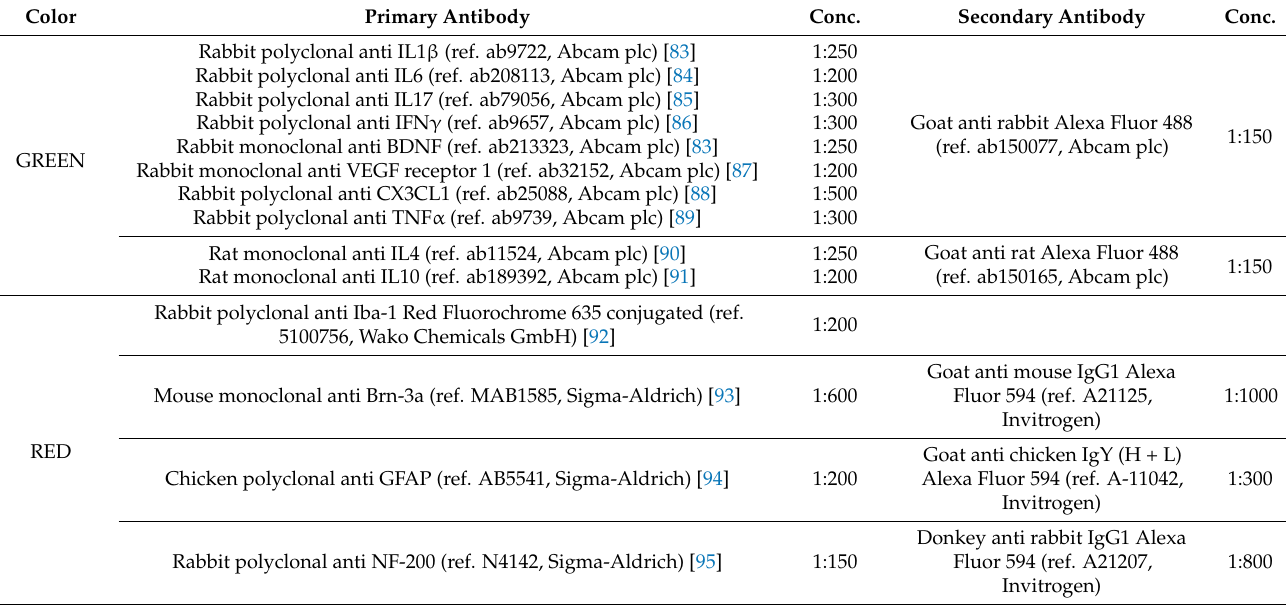
Table 2. Antibodies employed for the immunostaining